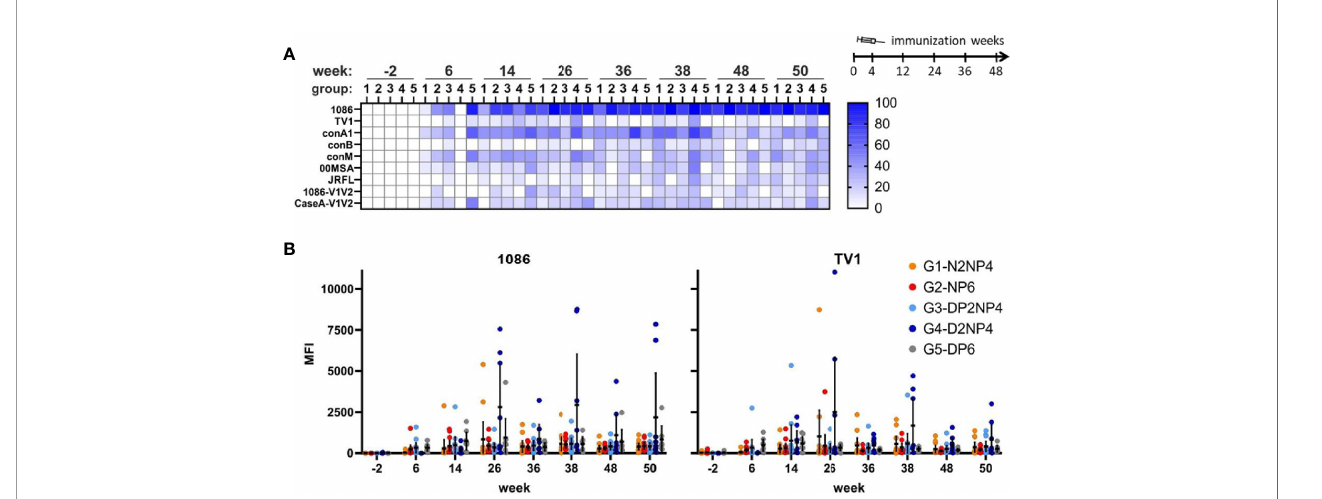
FIGURE 7 | Binding antibody multiplex assay of IgA in plasma samples. (A) Response rates of animals to the various readout antigens are indicated by color- intensity (scale on the right). (B) Time-courses for IgA responses (mean fl uorescence intensity [MFI] values of 1:40 diluted samples) towards selected readout antigens. Responses of individual monkeys are shown as colored dots and median and interquartile ranges are shown as black